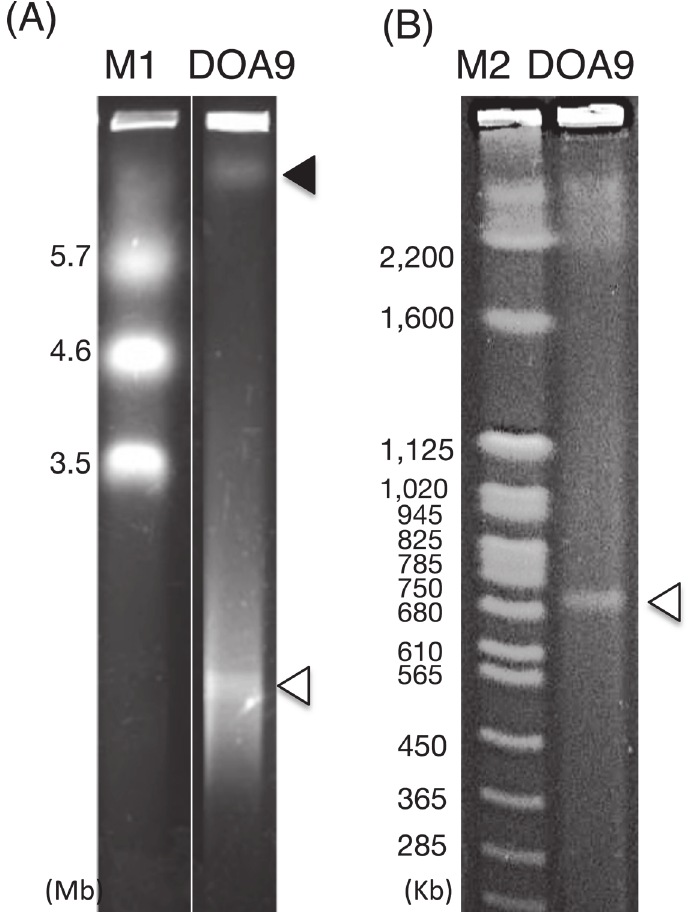
Fig 3. Pulse-field gel electrophoresis of Bradyrhizobium sp. DOA9 genomic DNA. DOA9 cells were digested in 1%pulse field grade (PFG) agarose plugs with proteinase K, as described inthe Materials and Methods, and run 0.8% certified megabase agarose in TAE buffer to separate fragments of 225 – 6,000 kb (A), or 1% certified megabase agarose in 0.5 x TBE buffer (B) to separate fragments of 225 – 2,200 kb, respectively. Closed arrowheads and open arrowheads indicate theputative chromosome and theplasmid, respectively. Lane M1: PFGE marker, 3.5 – 5.7 Mb, Saccharomyces pombe chromosomal DNA. Lane M2: low-range (2.03